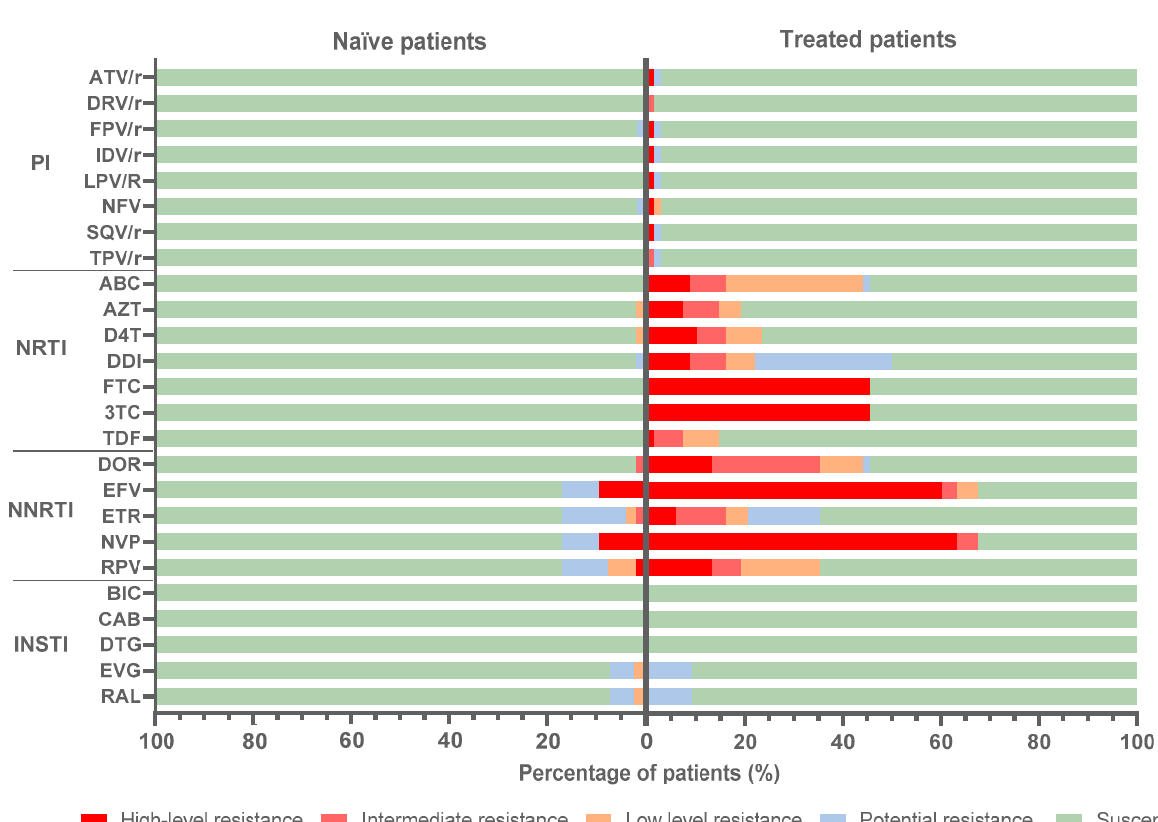
Figure 6. Predicted antiretroviral susceptibility in HIV-1 infected subjects in EG with available pol sequence from samples collected during 2019-2020. Data according to Stanfordv9.0 from 141 sub- jects with available sequences (131PR/121RT/97IN), 61 naïve (60PR/53RT/43IN) and 80 treated (71PR/68/RT/54IN), according to Table S1. Naïve, ART-naïve; treated, ART-treated; NRTI, nucle- oside reverse transcriptase inhibitors; NNRTI, non-NRTI; PI, protease inhibitors; INSTI, integrase strand transfer inhibitors. ATV/r, atazanavir/ritonavir; DRV/r, darunavir/ritonavir; FPV/r, fosam- prenavir/ritonavir; IDV/r, indinavir/ritonavir; LPV/r, lopinavir/ritonavir; NFV, nelfinavir; SQV/r, saquinavir/ritonavir; TPV/r, tipranavir/ritonavir; ABC, abacavir; AZT, zidovudine; D4T, stavu- dine; DDI, didanosine; FTC, emtricitabine; 3TC, lamivudine; TDF, tenofovir; DOR, doravirine; EFV, efavirenz; ETR, etravirine; NVP, nevirapine; RPV, rilpivirine; BIC, bictegravir; CAB, cabotegravir; DTG, dolutegravir; EVG, elvitegravir; RAL, raltegravir. Found intermediate and high resistance: 42.1% to NNRTI (48/121), 26.4% to NRTI (32/121) and 0.8% to PI (1/131). Information per patient in Figure